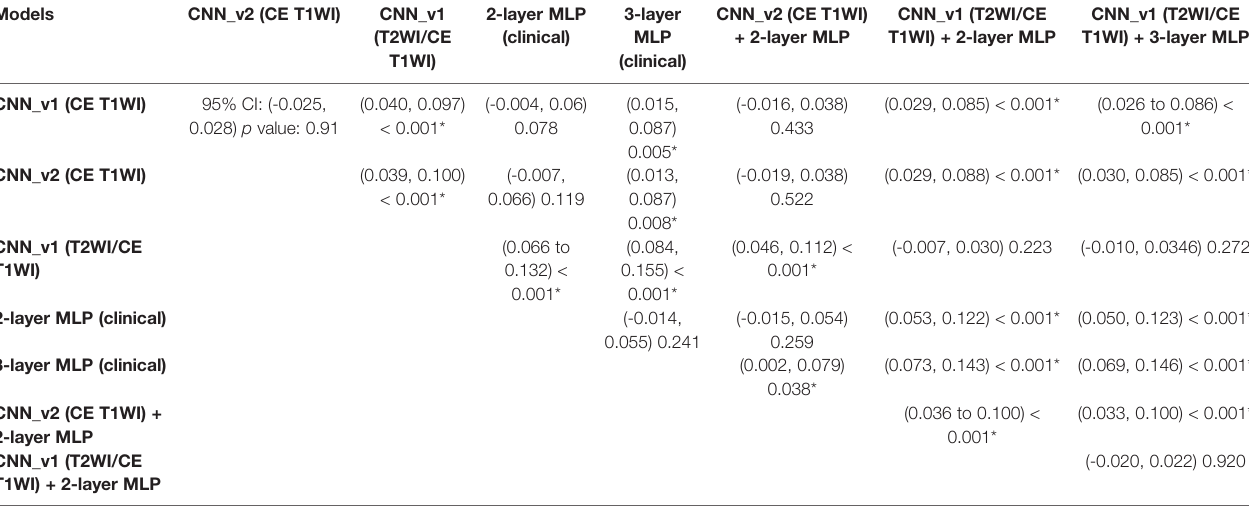
TABLE 3 | Comparison between ROC curves of CNN and MLP architectures for prediction of P/R in NFMAs.